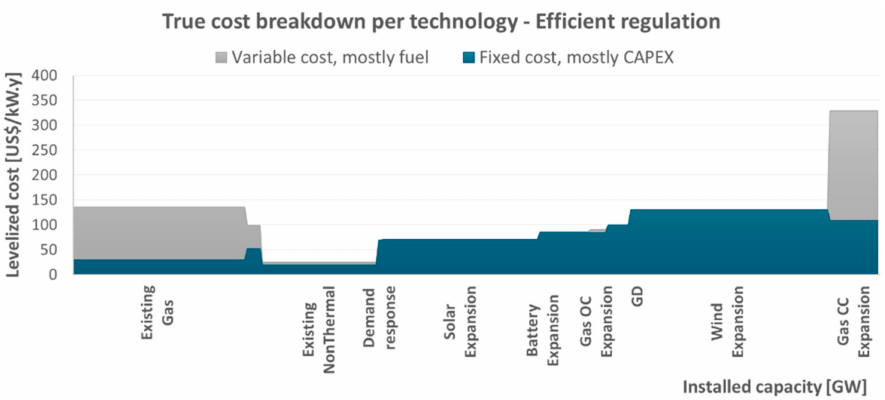
Figure 21. Cost breakdown in the efficient regulation scenario. Total cost (variable + fixed) equal to USD 22.8 billion.